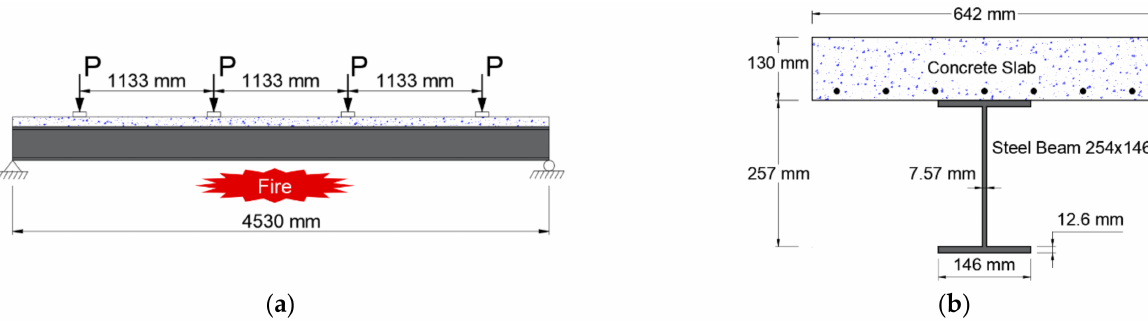
Figure 7. Tested beam layout used in validation model: ( a ) Boundary and loading conditions; ( b )